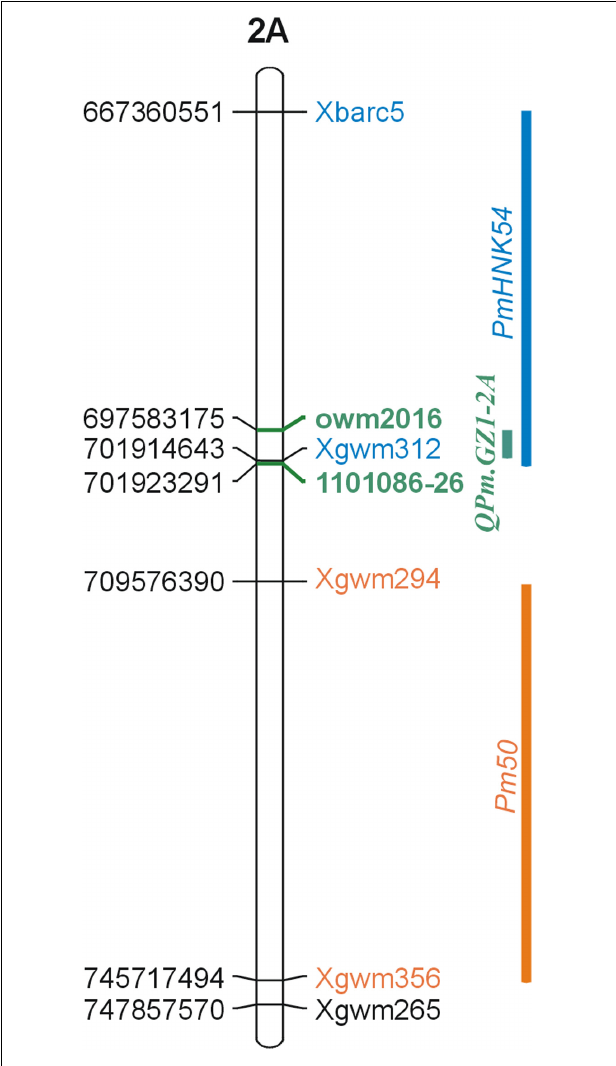
FIGURE 4 | Genomic comparison of known powdery mildew resistance loci adjacent to the QPm.GZ1-2A locus. The reference genome sequence of cv. Zavitan was used to analyze the QPm.GZ1-2A locus position on the genome level. The QPm.GZ1-2A locus (green bar) is flanked by the owm2016 and 1101086-26 markers (green) overlapping the PmHNK54 locus (Xu et al., 2011, blue) and neighboring the Pm50 locus. Mohler et al. (2013) located the Pm50 3.8 cM distally from the Xgwm294 marker and it does not overlap with the QPm.GZ1-2A locus. PmHNK54 was mapped 6 cM proximally to the Xgwm312 marker. The QPm.GZ1-2A and PmHNK54 loci share about 4.3 Mb of the 31 Mb PmHNK54 region between the Xgwm312 and Xbarc5 markers; however, PmHNK54 was found to be dominant and is different from the recessive QPm.GZ1-2A